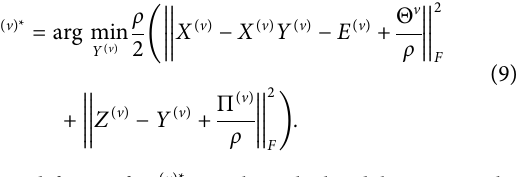
Algorithm 1: WLRTR for multi-view subspace